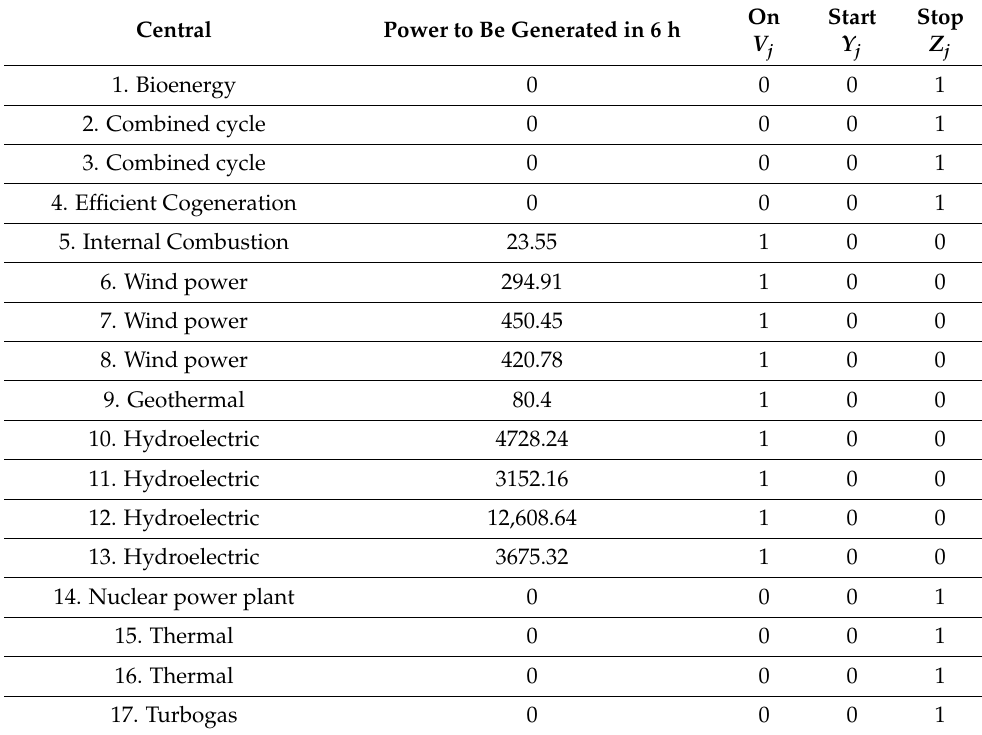
Table 6. Results of period 4. Central Power to Be Generated in 6 h